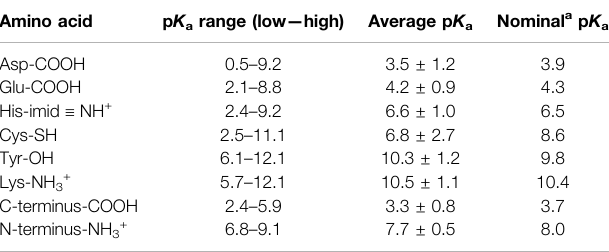
TABLE 2 | Aqueous pK a values for amino acids that can have signi fi cant concentrations of both protonated and deprotonated forms around pH 7. Data are from 541 pK a values reported under various conditions for 78 folded proteins (Pace et al., 2009). Amino